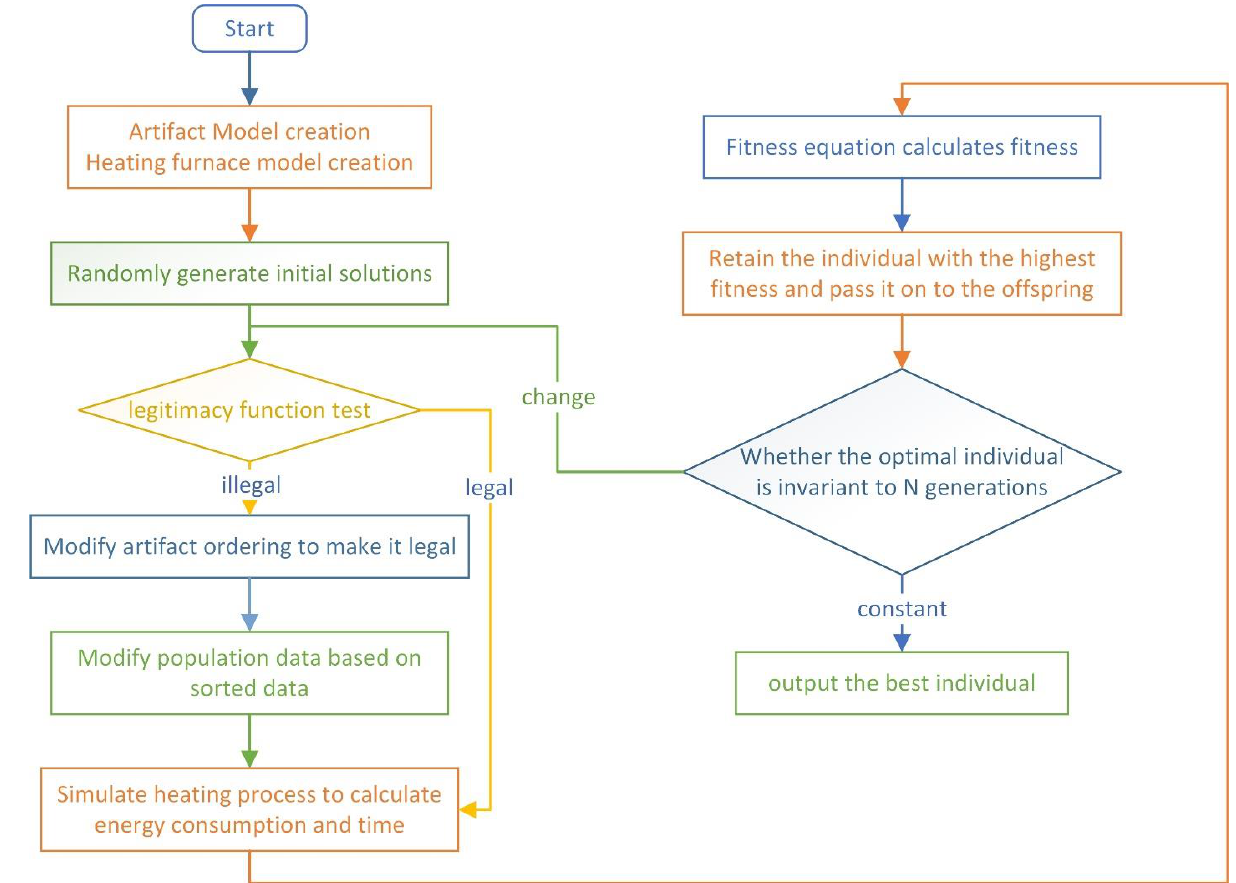
Figure 2. Schematic diagram of scheduling optimization analysis process based on genetic algo- rithm.